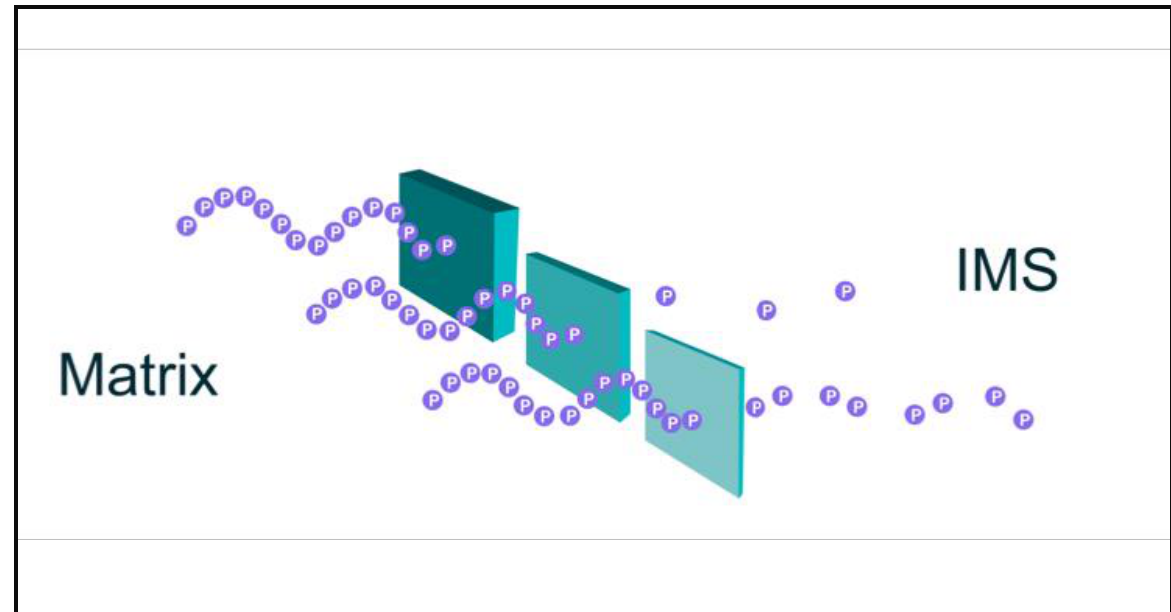
Figure 1. Cartoon of proton tunneling. Protons pumped from the mitochondrial matrix into the intermembrane space (IMS) must overcome electrostatic repulsion of other protons (already in the IMS?) and likely avoid “irreversible” solvation by water. These are but two of likely several energy barriers that protons must overcome, and “quantum tunneling” may provide a mechanism to overcome energy barriers experienced by protons moving into the IMS and increase rates of proton pumping.